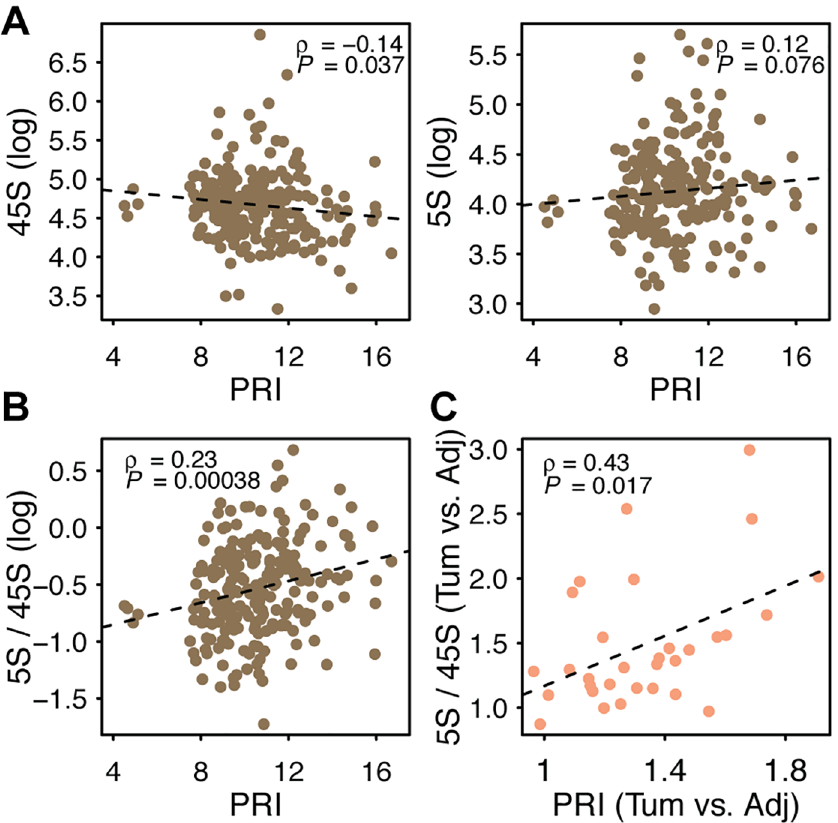
Fig 8. Associations between tumor proliferation and rDNA copy number. (A-B) Spearman rank correlationsbetweenPRI (YW geneset) and 45S CN, 5S CN and 5S/45S ratio in LUAD tumor samples. (C) Changesin tumor PRI relativeto normal adjacent tissue are positivelycorrelatedwith changesin the 5S/45S ratio betweentumor and normal adjacent tissue. The 31 LUAD patients with paired adjacent-tumor data (DNAseq and RNAseq) were used in